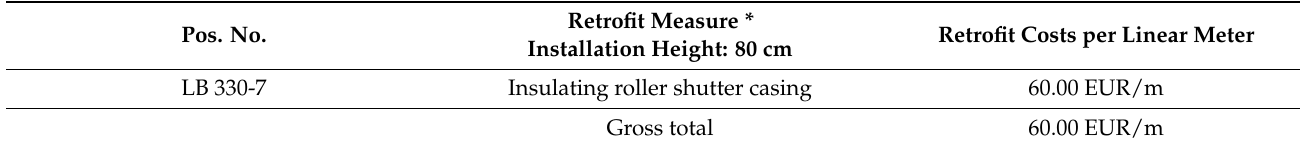
Table A20. Retrofit components and costs of the thermal bridge retrofit of a roller shutter casing [38,39]. Pos. No.